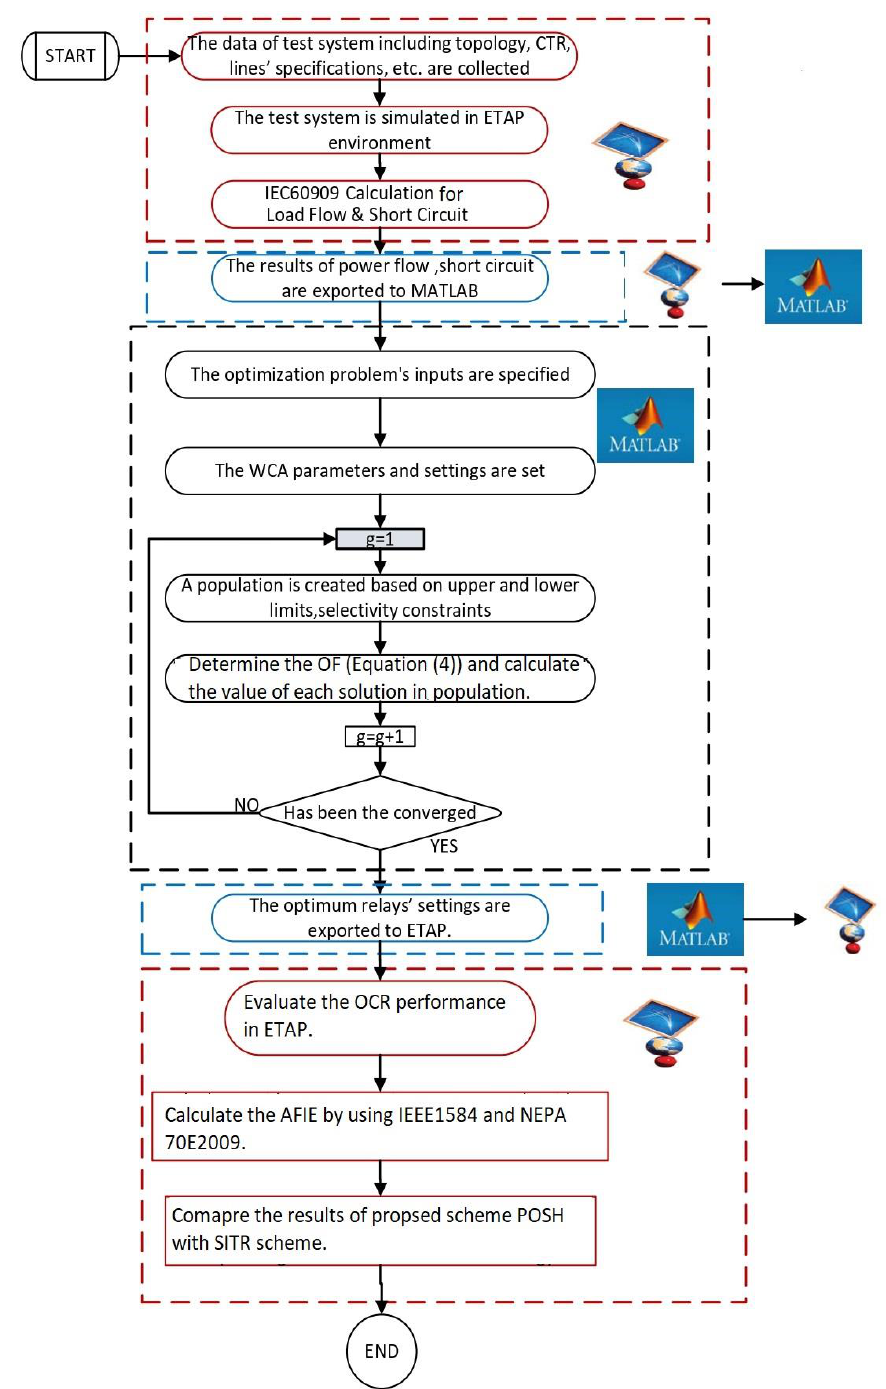
Figure 3. The process and work-flow of the proposed protection scheme (POSH)for OCRs considering AFIE.